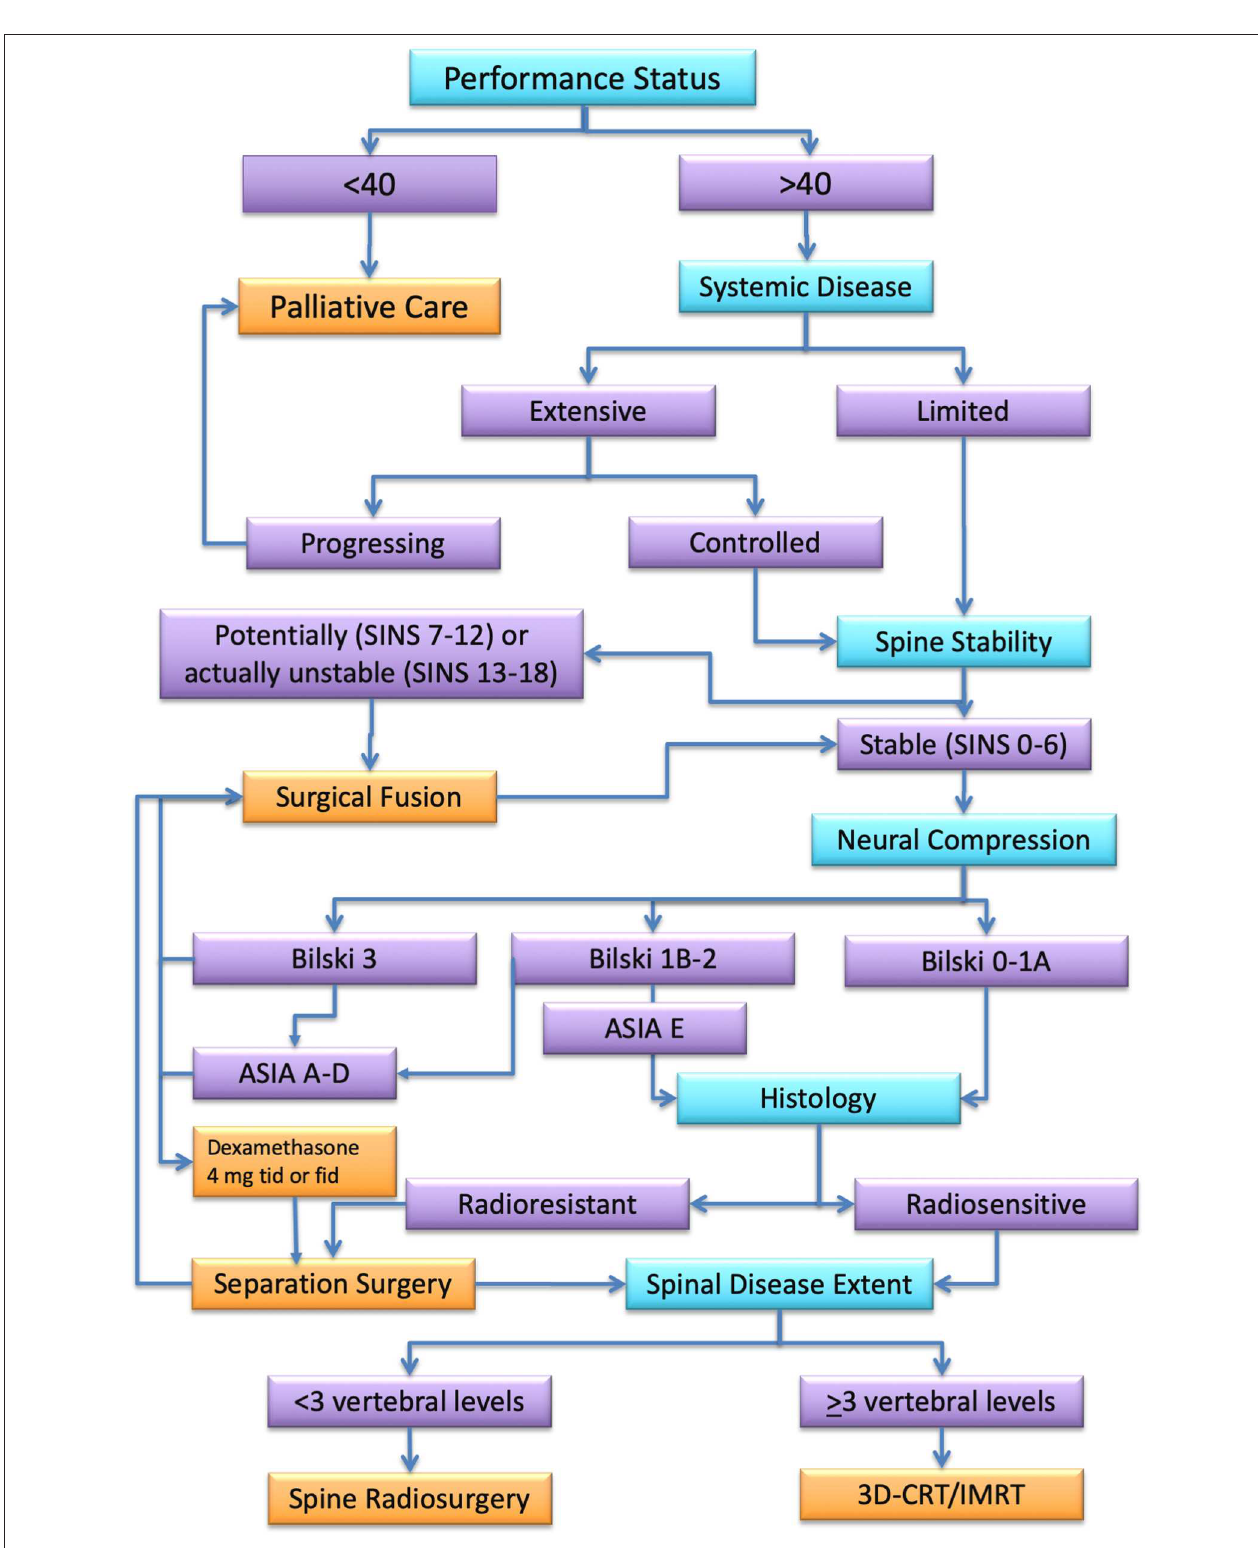
FIGURE 4 | Algorithm for spinal metastasis treatment. In turquoise, the assessment steps. In orange, the best treatment option for each assessment category (in purple) according to the literature review.